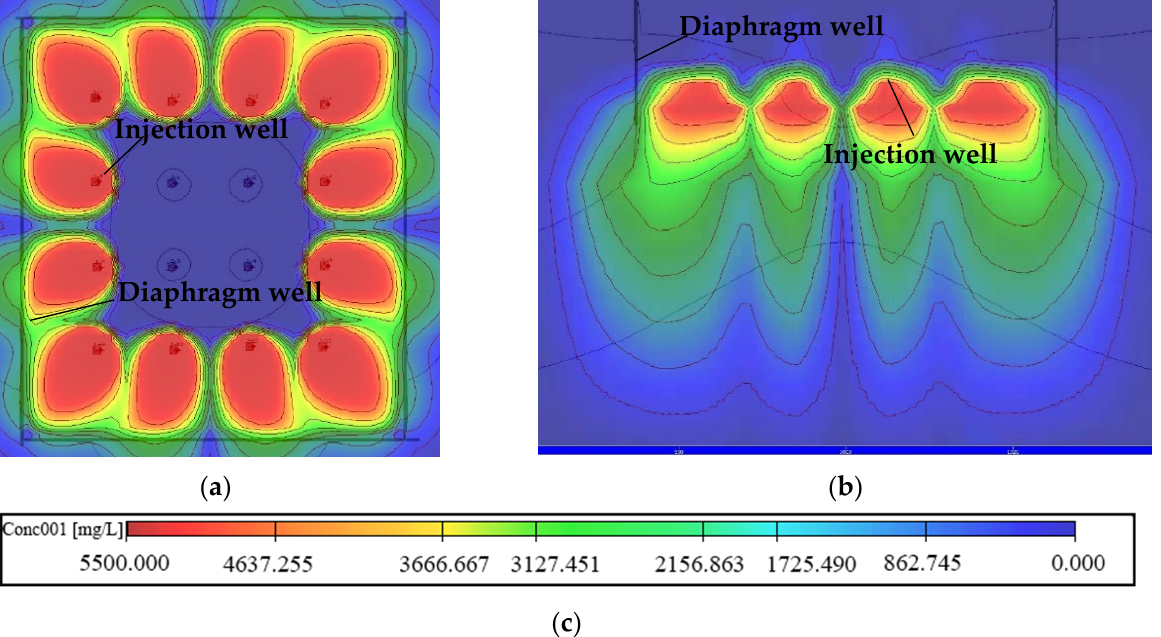
Figure 15. Migration of S. pasteurii after 4 days in condition 5: ( a ) Horizontal; ( b ) Vertical; (c) Legend.